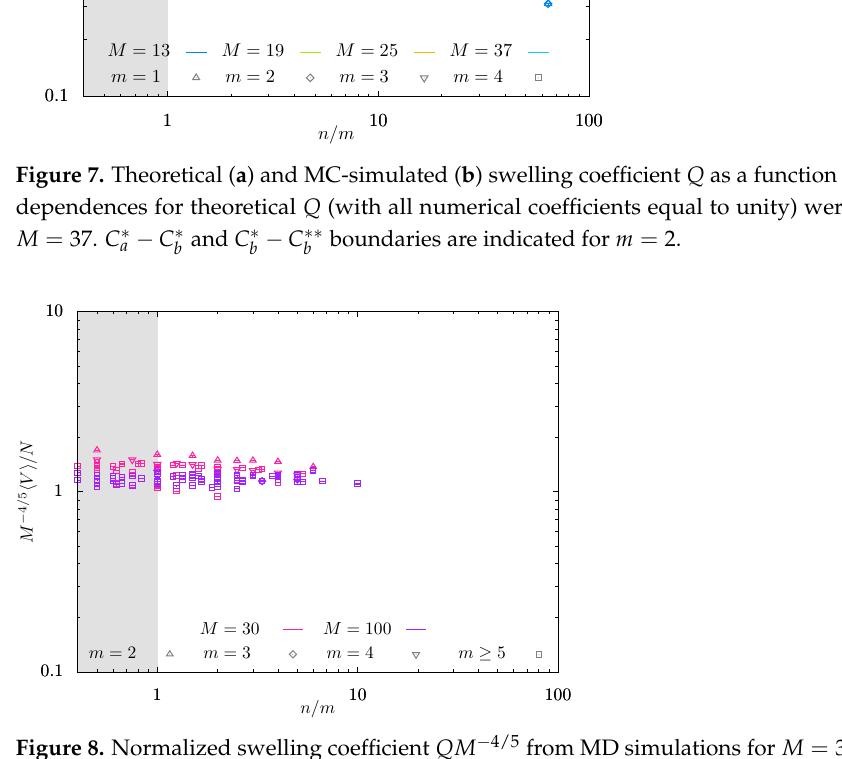
Figure 8. Normalized swelling coefficient QM − 4/5 from MD simulations for M = 30 (red symbols) and 100 (violet symbols) as a function of n / m